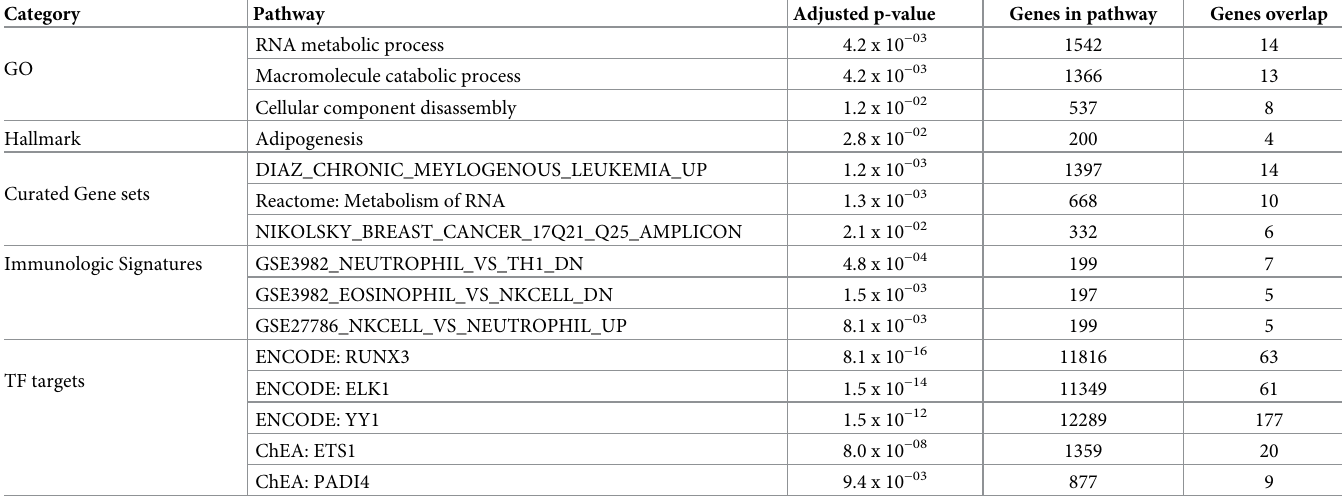
Table 4. Different categories of pathways enriched for the 73 genes associated (FDR < 0.05) with overall survival (OS).